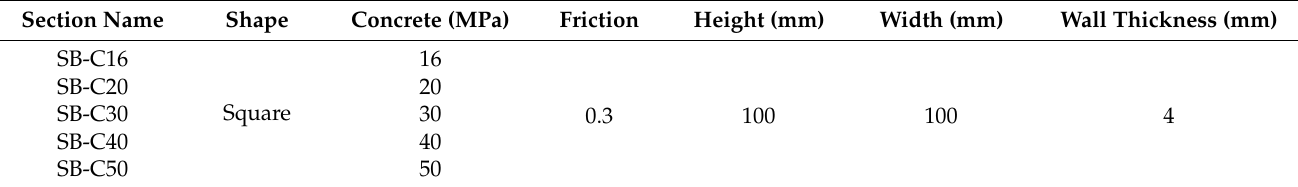
Table 5. Compressive strength of different concrete